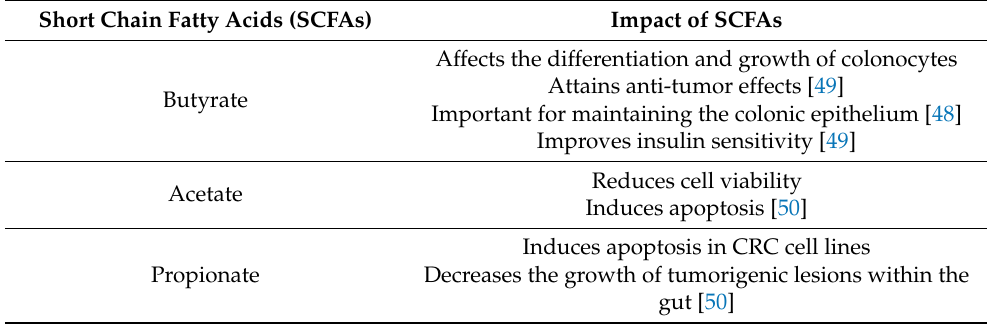
Table 4. The consumption of fiber leads to the production of SCFAs. Of most interest are butyrate, acetate and propionate all three of which hold anti-tumor effects and allow for the reduction in risk of developing